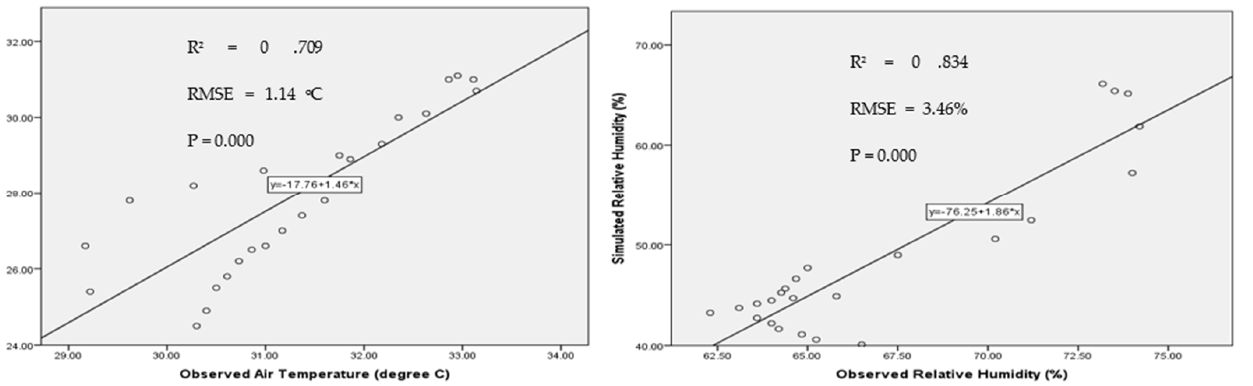
Figure 7. Measured and simulated results of diurnal and nocturnal air velocity at SM.